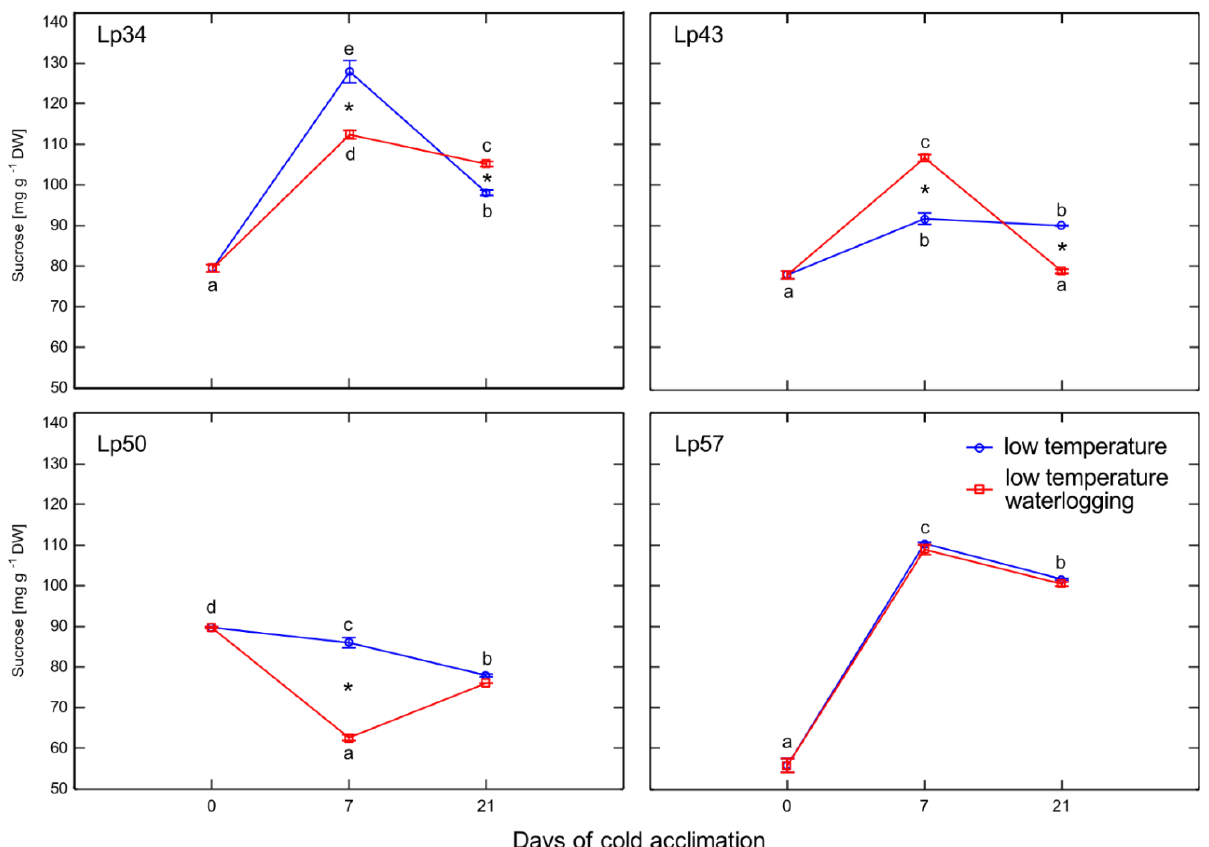
Figure 7. Sucrose content of cold-acclimated Lolium perenne genotypes. Four genotypes (Lp34, Lp43, Lp50, and Lp57) were tested. The results are means ( n = 4), error bars indicate the standard error. Asterisks indicate means that differ significantly between waterlogged and control plants according to one-way ANOVA ( p < 0.05). Different lower-case letters indicate means that are statistically different according to Duncan’s multiple range test ( p < 0.05).